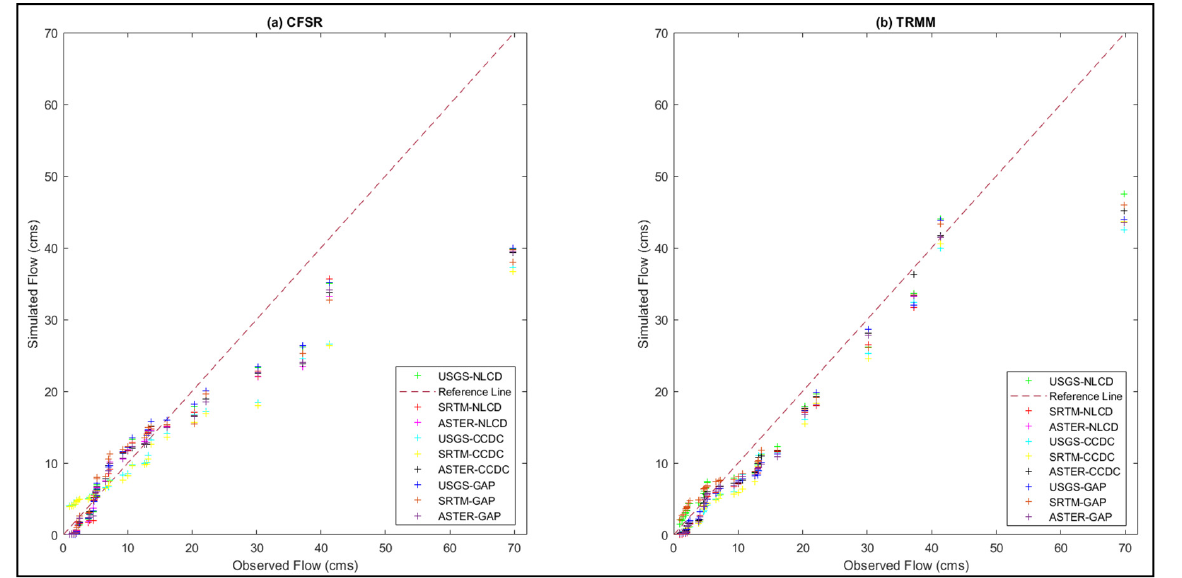
Figure 15. Variation of simulated flows with observed flows was obtained for the two precipitation datasets: ( a ) CFSR and ( b ) TRMM, with nine different combinations for the Baron Fork watershed.